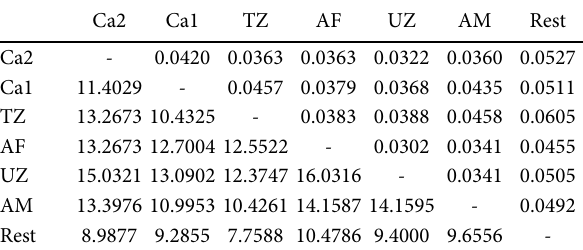
Table 4. Pairwise G ST (above diagonal) and Nm (below diagonal) values recorded between Tropidurus hispidus populations. For acro- nyms, please refer to Table